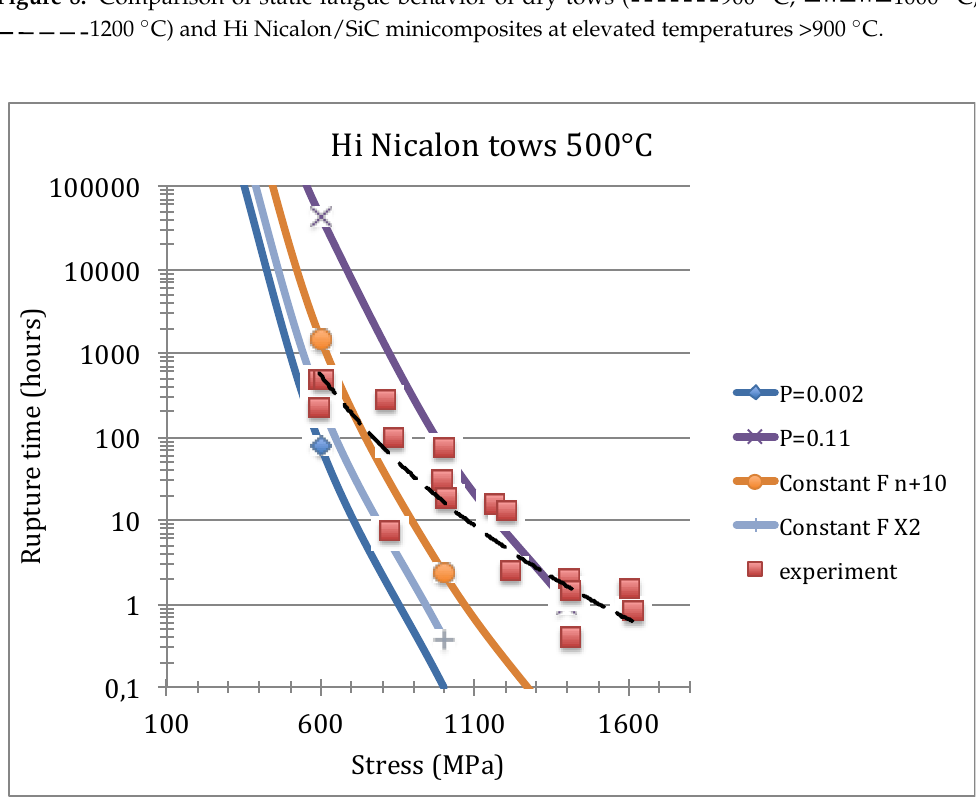
Figure 9. Static fatigue at 500 °C on SiC Hi Nicalon dry tows: comparison of experimental stress– rupture time diagram with predicted stress–rupture time curves for critical filaments (defined by failure probabilities P = 0.002, P = 0.11); and then considering failures of groups of 10 filaments (n + 10) or groups with sizes doubled at each step (X2) [21].